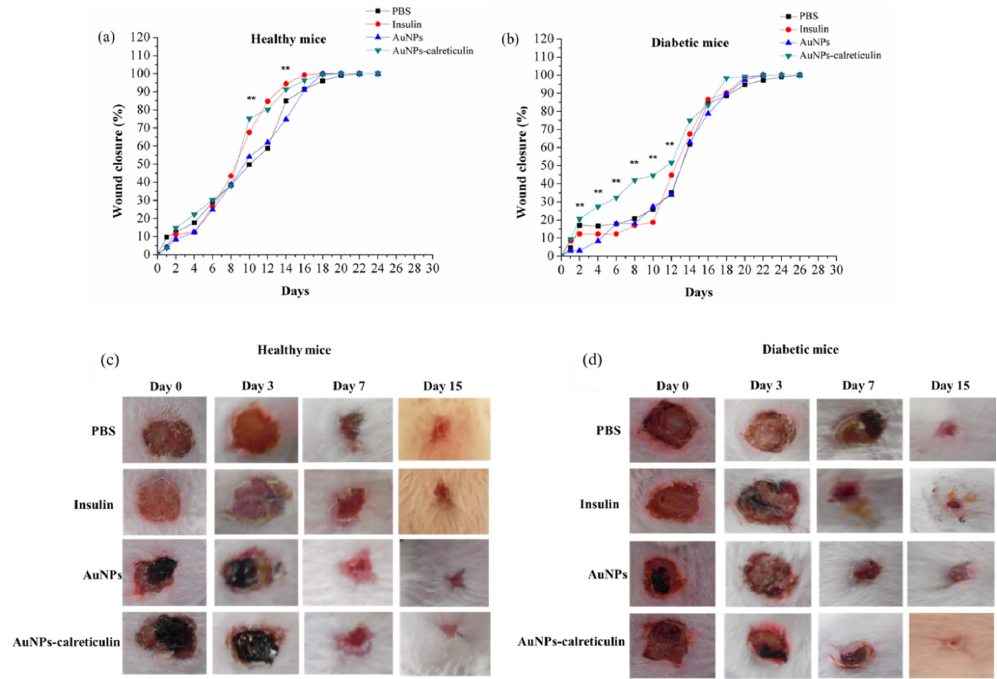
Figure 10. Healing of wounds of the dorsum in mice. Percent of closure of wounds in ( a ) healthy mice and ( b ) diabetic mice. Macroscopic view of closure wound at 0, 3, 7, and 15 days in ( c ) healthy mice and ( d ) diabetic mice. A reduction of the area was observed in wounds treated with AuNPs–calreticulin in both groups.